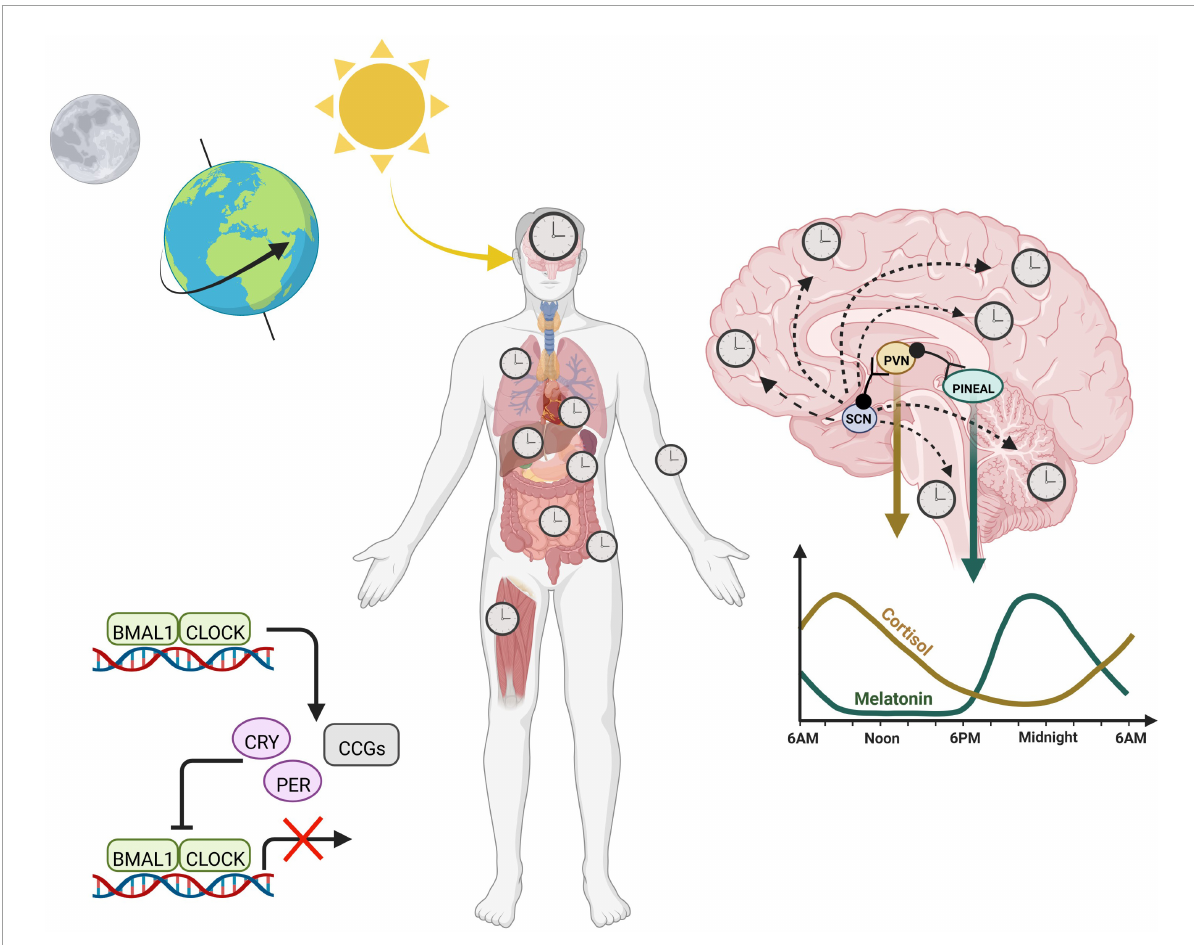
FIGURE1 Circadian rhythms across the body are entrained by the 24-h environment. Diurnal light exposure entrains the “master clock”, known as the suprachiasmatic nucleus (SCN). The SCN coordinates daily rhythms in the brain as well as the periphery via a combination of neuronal signals and hormones, including cortisol and melatonin, which fluctuate opposite to each other and promote sleep/wake cycles. At the cellular level, the core transcription translational feedback loop in the nucleus is characterized by BMAL1 and CLOCK binding to E-box containing genes to regulate transcription of numerous clock controlled genes (CCGs) including their own repressors, PERIOD (PER) and CRYPTOCHROME (CRY). Heterodimers PER and CRY translocate back into the nucleus to inhibit the CLOCK:BMAL1 complex, thereby inhibiting their own